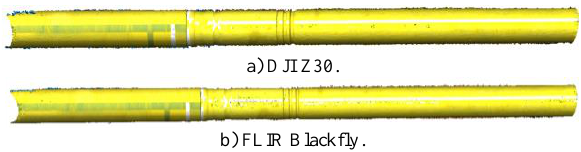
Figure 15. Horizontal view of the successful reconstructed 3D textured meshes of the riser from simulated acquisition of an inspection scene (with riser and sea movement) using the developed CNN-based strategy for riser background removal.